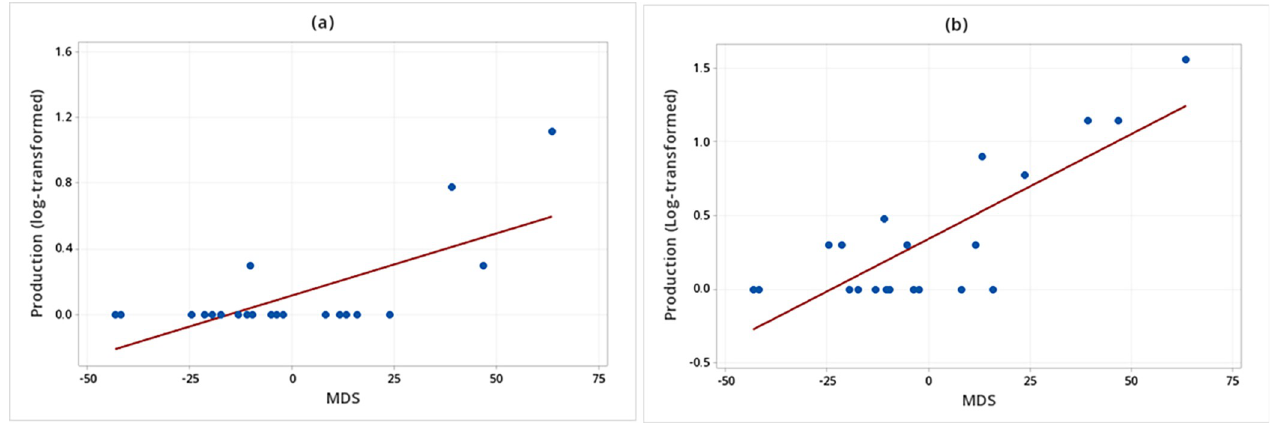
Fig 2. Relationship between the sender’s social rank (MDS) and the production of multimodal signals. (a) White-lipped peccaries (N = 21) were displaying threatening behaviors after a unimodal signal fails. (b) Animals were displaying threatening behaviors without a previous failure.